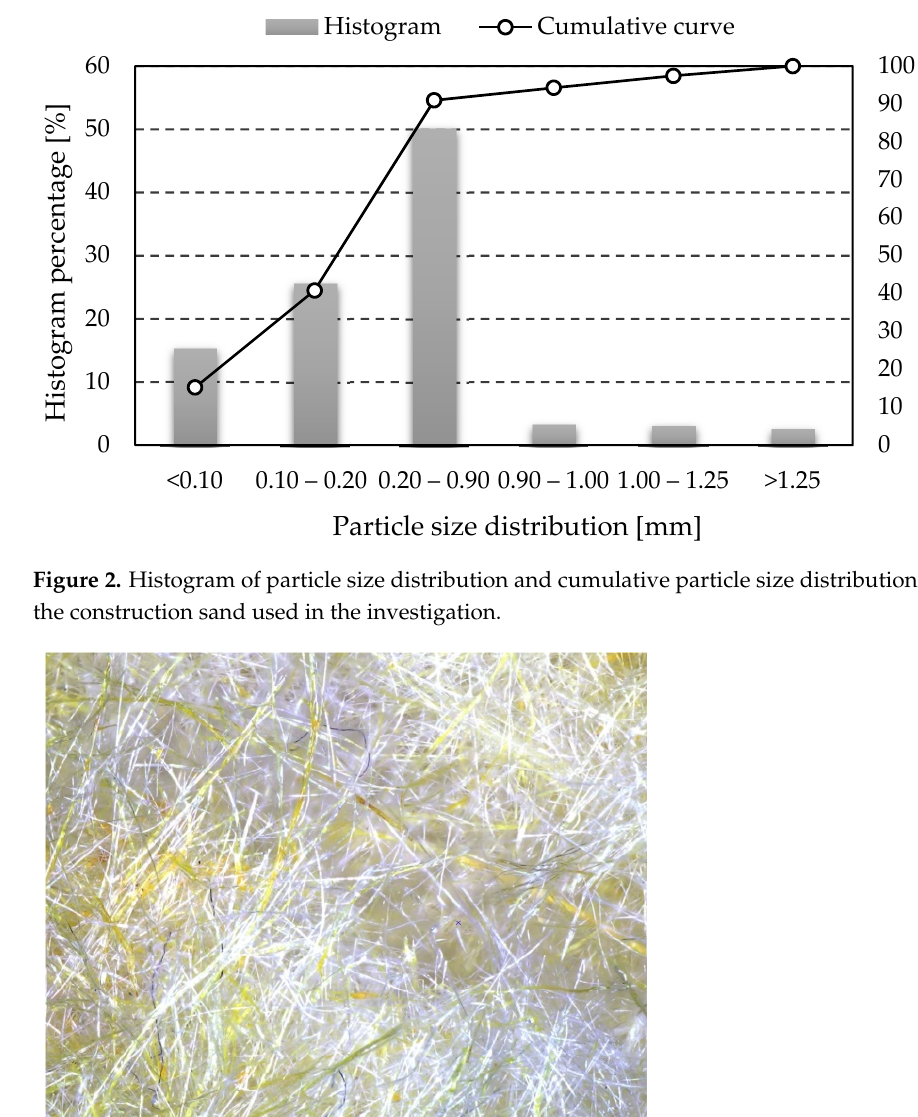
Figure 3. Glass wool waste added to geopolymer composites.